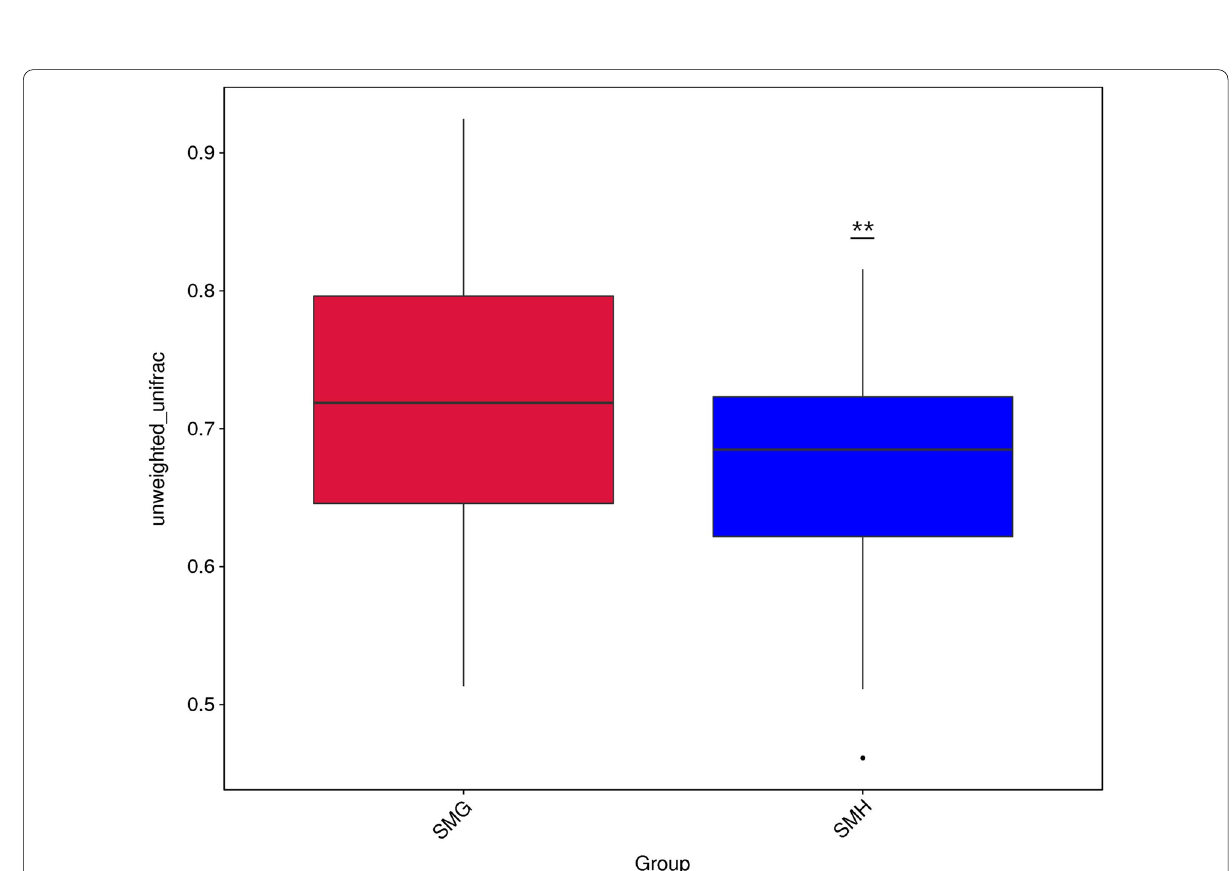
Fig. 3 Beta diversity test between different sampling locations based on unweighted unifrac